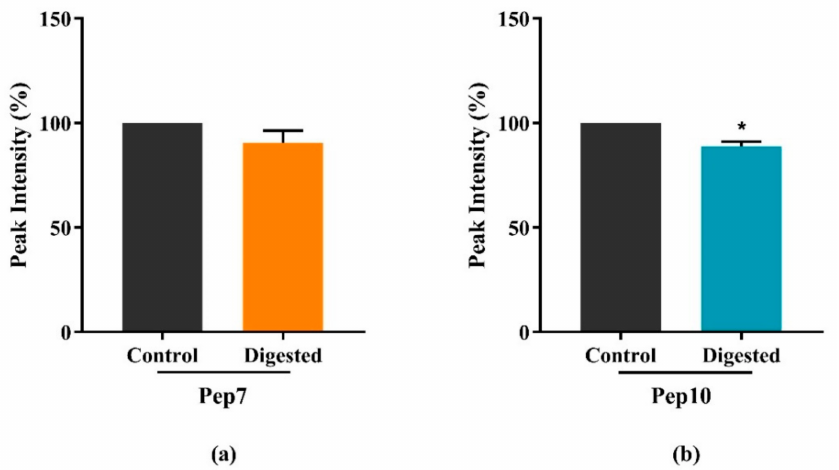
Figure 5. Stability evaluation of Pep7 ( a ) and Pep10 ( b ) stability by in vitro simulated GI digestion. Bars represent the average ± SD of 3 independent experiments in duplicates. Data were analyzed by Student’s t-test and the Mann–Whitney test. * p < 0.05 versus undigested samples